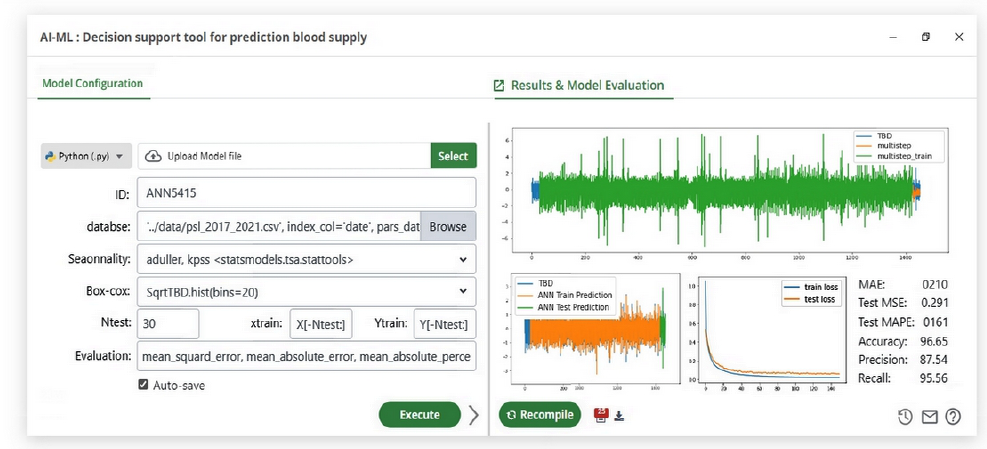
Figure 7. AI/ML module configuration overview and run results